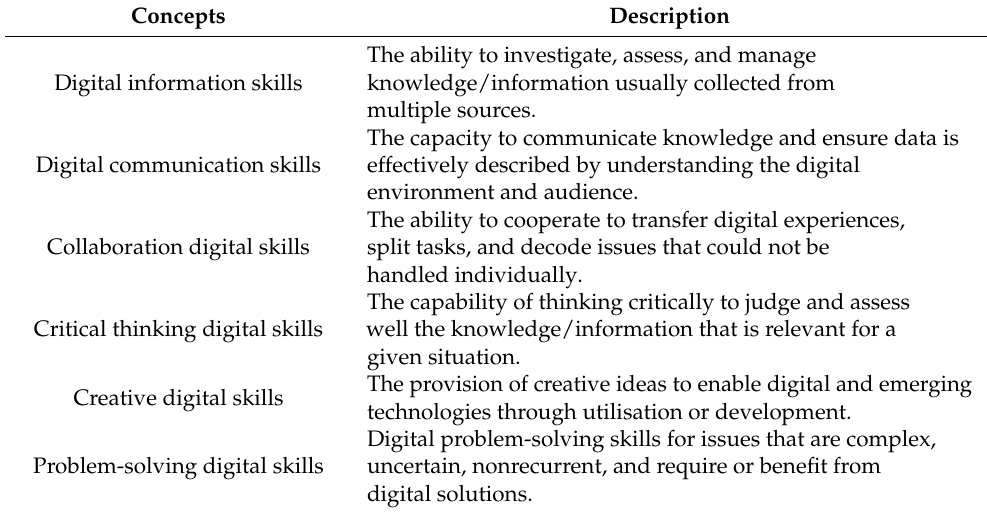
Table 1. The study concepts and description. Concepts Description Digital information skills